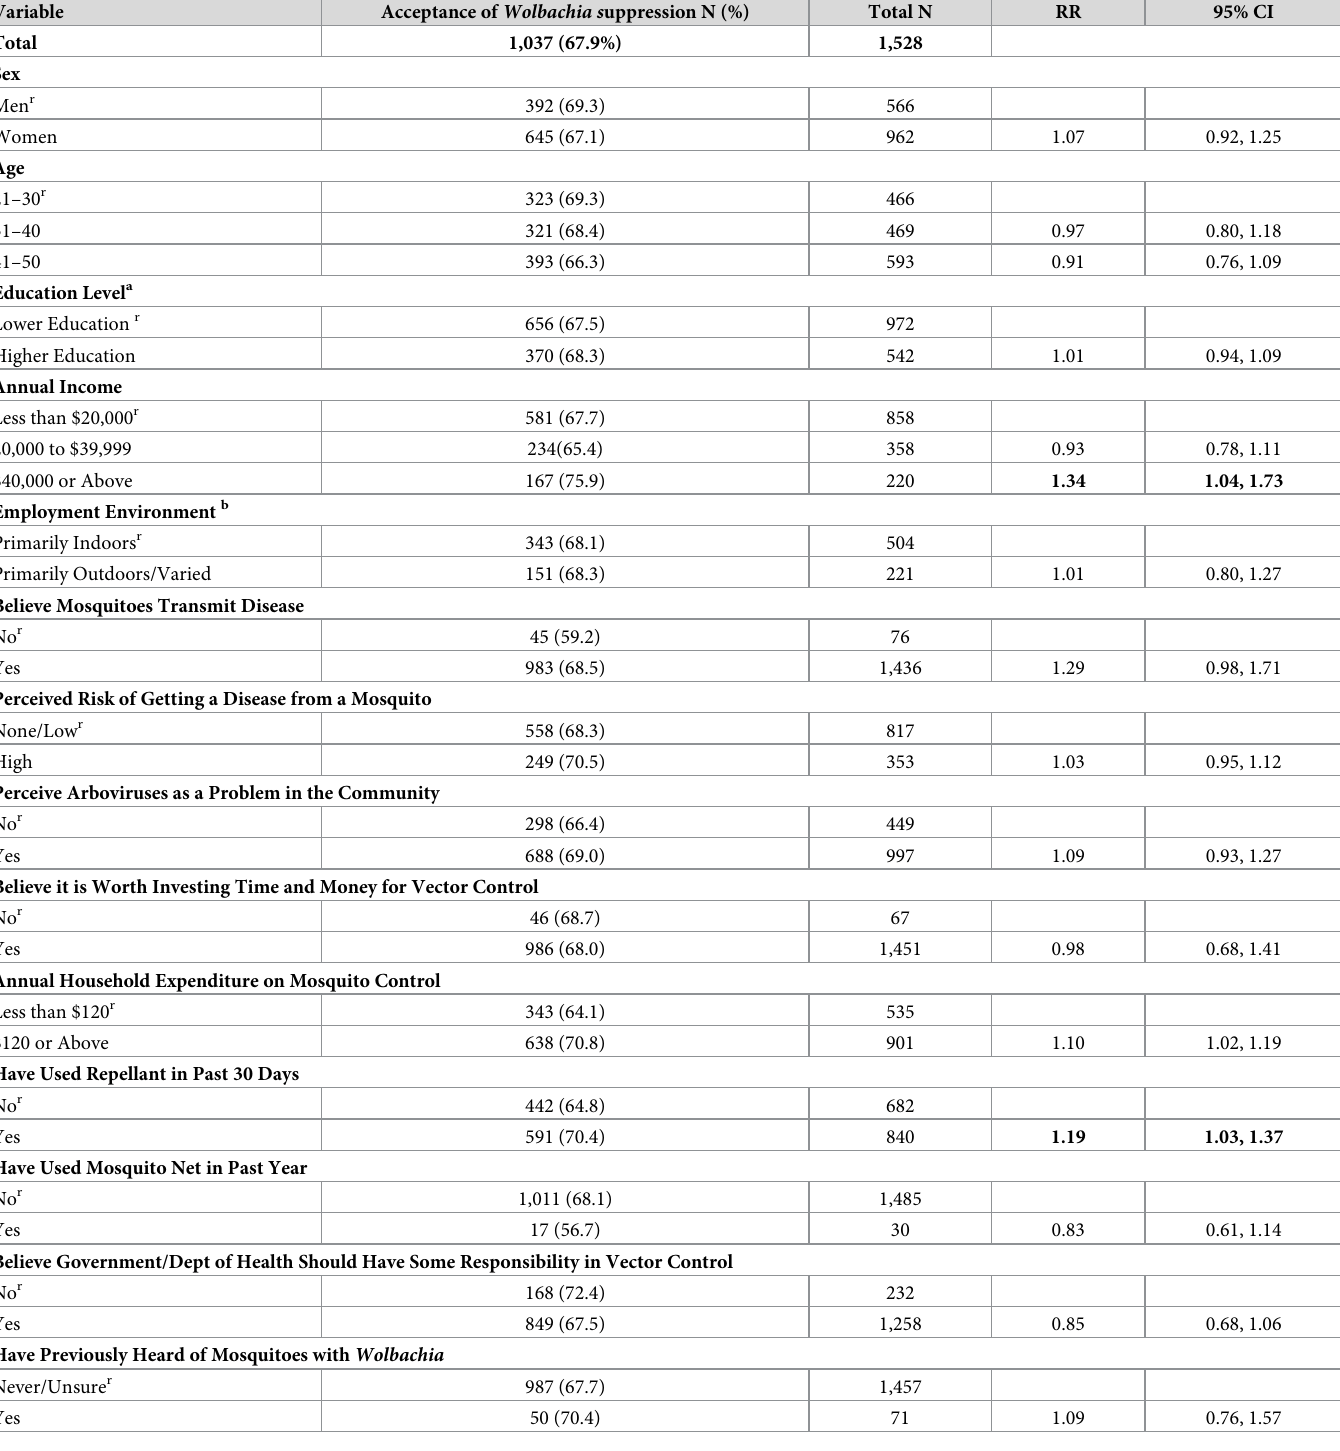
Table 2. Factors associated with Wolbachia suppression support, COPA, Ponce, Puerto Rico,